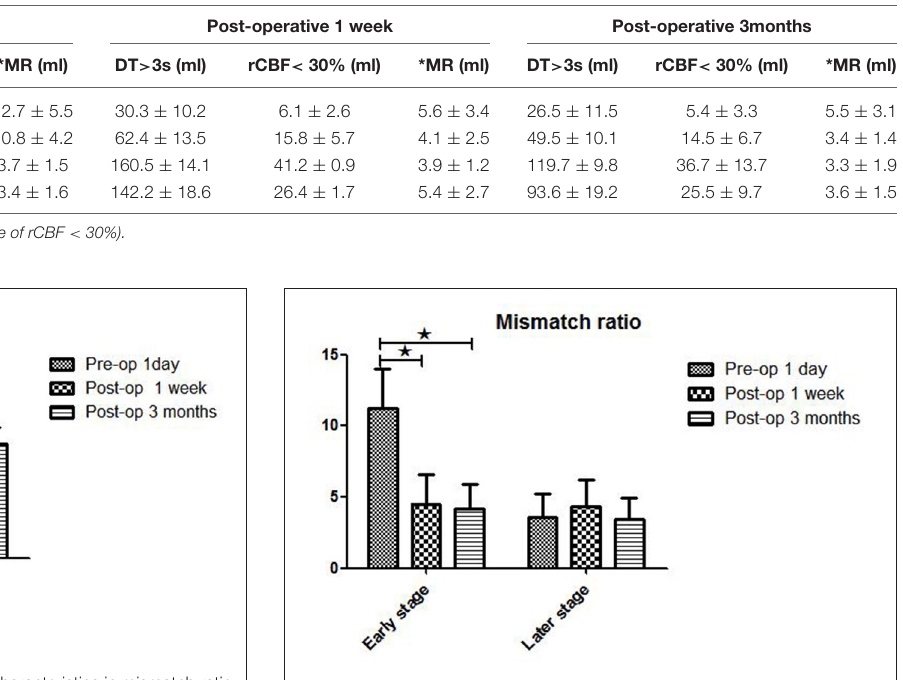
FIGURE 5 | WB-CTP showing hemodynamic characteristics in mismatch ratio in ischemic MMD patients of different Suzuki stages (early and later stage) at different time points. Early stage: in Suzuki stage II and III Later stage:in Suzuki stage IV and V. *MR, mismatch ratio (volume of DT > 3 divide volume of rCBF < 30%), ⋆ P <